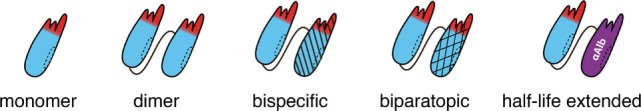
Schematic representation of di- and multimeric antitumor nanobodies. Owing to their high solubility and stability nanobodies can readily be fused genetically to other nanobodies without the mispairing and solubility issues inherent to single-chain variable fragment-based dimers and multimers. Flexible glycine–serine linkers are commonly used to fuse nanobodies, e.g., one or more tandem modules of G4S composed of four glycine residues to provide maximal flexibility and a hydrophilic serine residue to improve solubility. Tandem fusion of two identical nanobodies yields a bivalent dimer, often with improved avidity over the respective monomer. Tandem cloning of two distinct nanobodies that recognize non-overlapping epitopes of the same antigen yields a biparatopic binder. Fusion of two nanobodies recognizing distinct cell surface proteins yields a bispecific binder. The in vivo half-life can be extended by fusing one or more antitumor nanobodies to an albumin-specific nanobody. Piggy-backing on albumin reduces the loss of antitumor nanobodies by renal filtration.